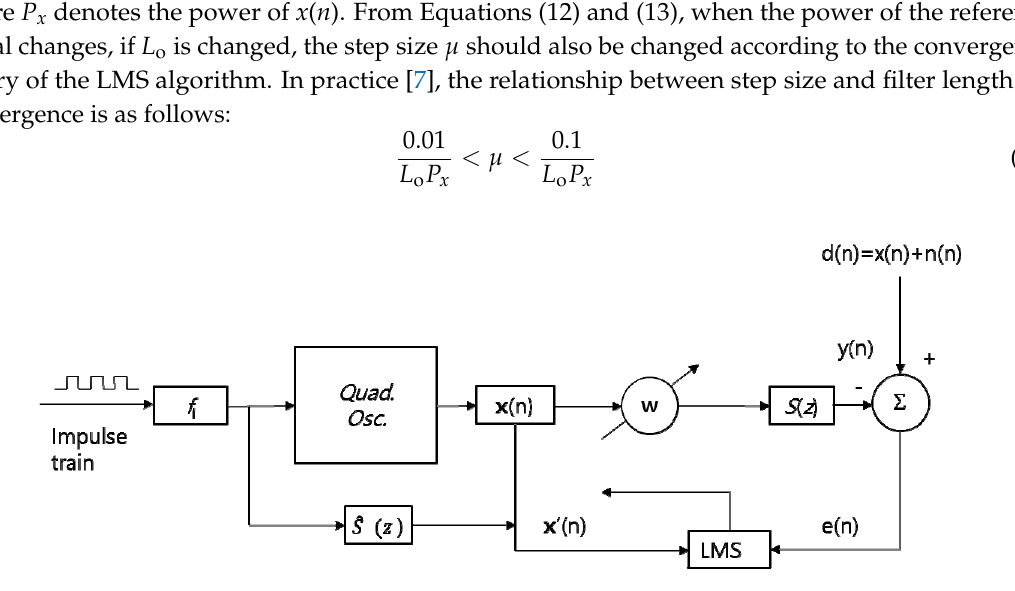
Figure 2. OW-FxLMS control algorithm based adaptive filter with optimized weights (OW).